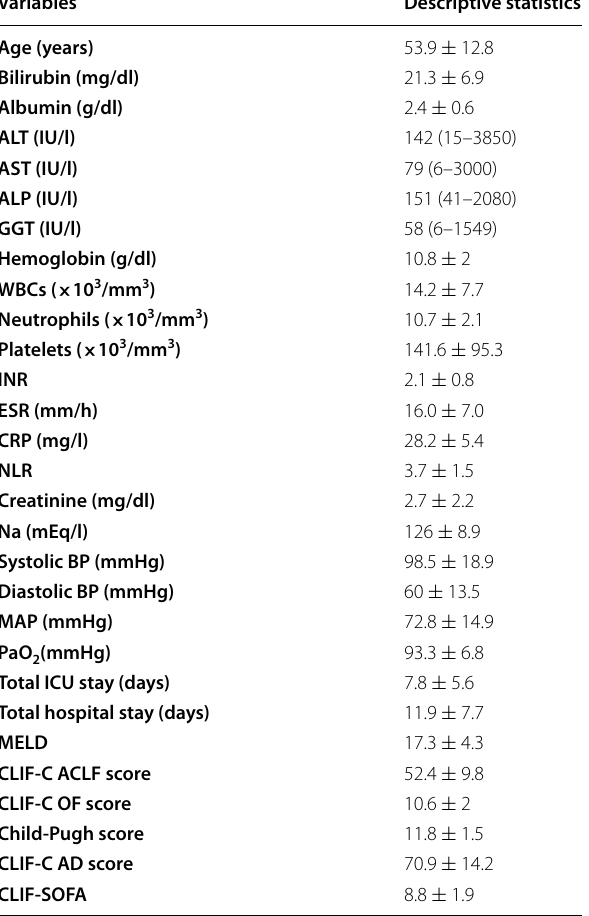
Table 1 Baseline characteristics of the studied patients (quantitative variables)